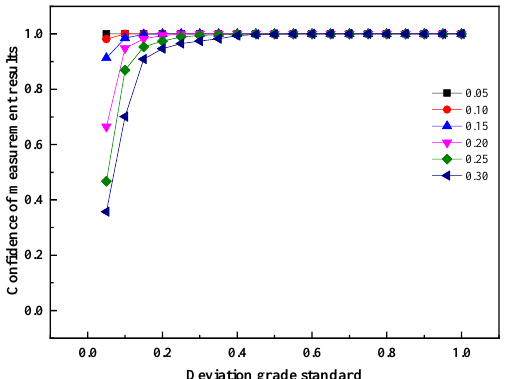
Figure 32. Relationship between deviation grade standard and confidence of measurement results under different relative standard deviation of velocity at mean velocity 1.35 m/s.